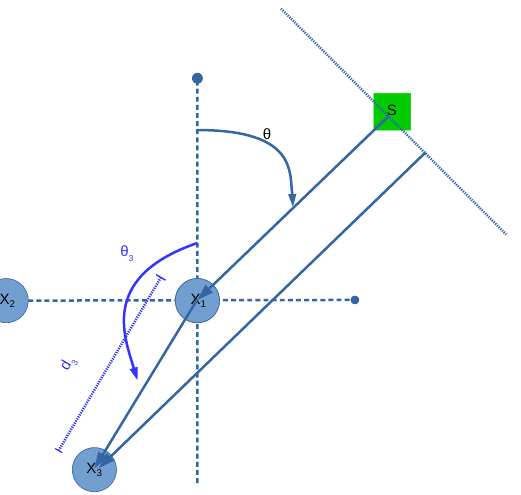
Figure 1. A possible frame of reference, in this case a triangular array, where θ 3 is exemplified. The green square is the SOI ( S ) and each blue circle is a microphone ( X m